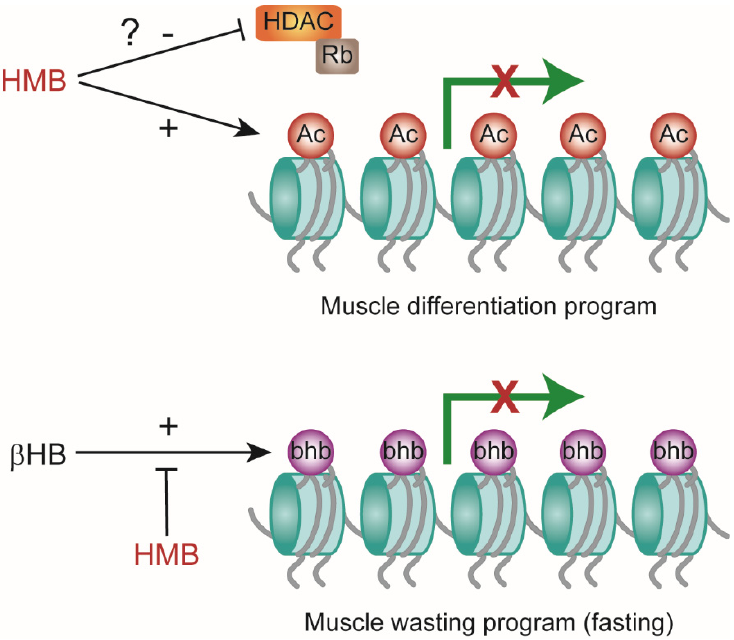
Figure 5. Schematic representation of β -Hydroxy- β -Methyl Butyrate (HMB) and β -Hydroxybutyrate ( β HB) effects on histones modification and gene expression. Ac: acetylation; bhb: β -hydroxybutyrylation. + (plus) denotes activation/induction; - (minus) denotes inhibition/blockade.